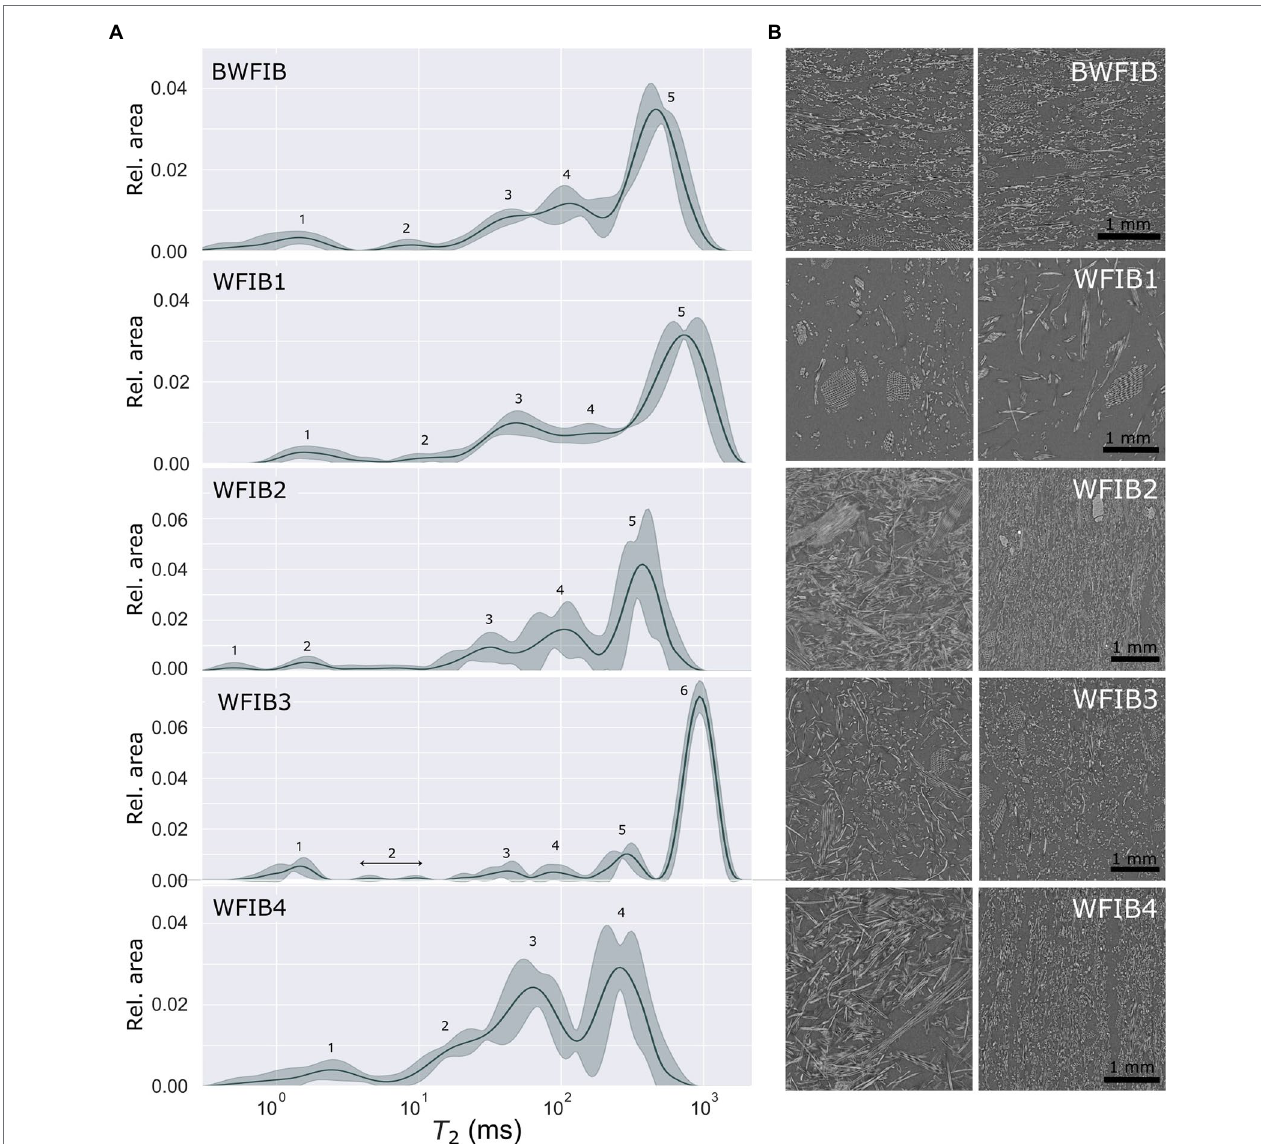
FIGURE 5 | (A) Continuous T 2 distributions (with peak numbers 1–6) of five wood fibre insulation materials, showing the mean value (line) and standard deviation (filled zone); (B) X-ray CT section of the wood fibre insulation boards, appr. 4 × 4 mm 2 , showing the center of the specimen seen from the front (left) and the side (right) for each specimen (5 × 5 × 10 mm 3 ). BWFIB = Bituminised wood fibre board and WFIB1-4 = Wood fibre insulation board type